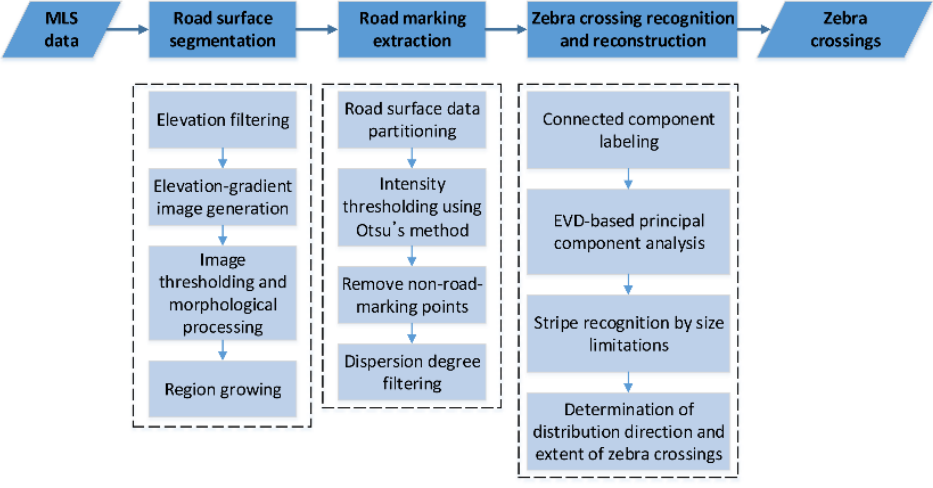
Figure 1. The flowchart of the method.